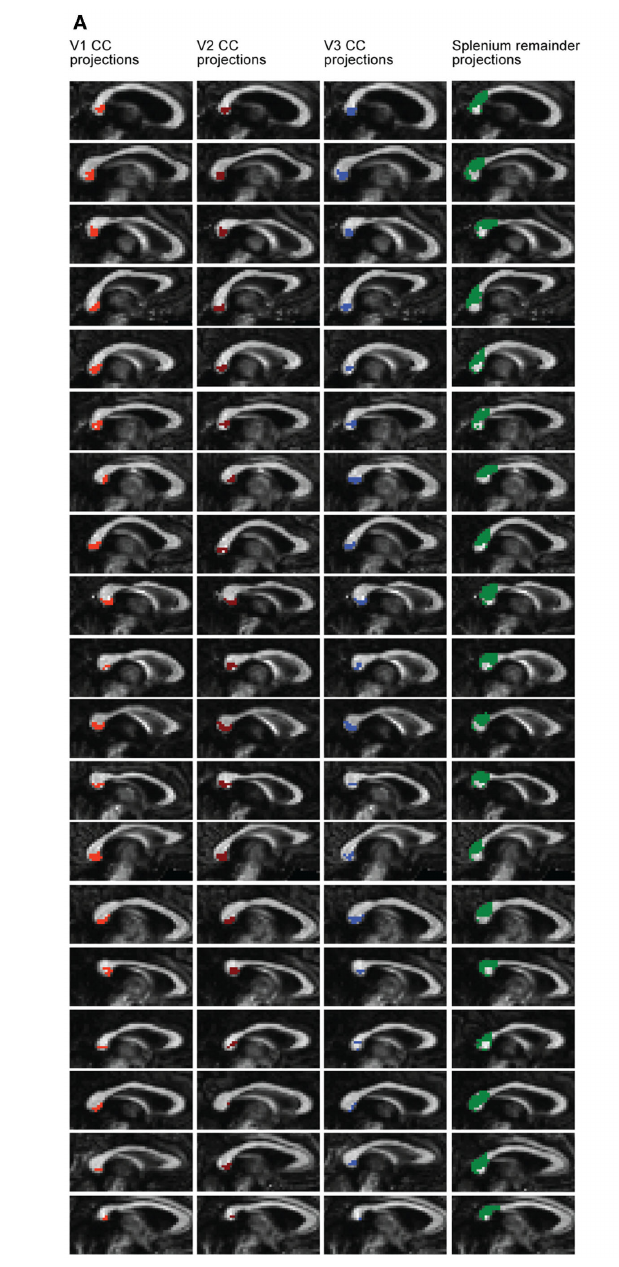
segments. Individual CC segments were non-linearly transformed into MNI space. Only voxels are displayed that were part ofV1,V2,V3 CC segments in at least 14 out of 19 participants. (C) Schematic description of subregions in the CC.The subregions forV1 (orange) andV3 (blue) were defined according to the fiber tracking results. Because theV1 and V3 subregions overlapped in most participants, an additional regression was performed with the “intersection” and “exclusive” segments ofV1